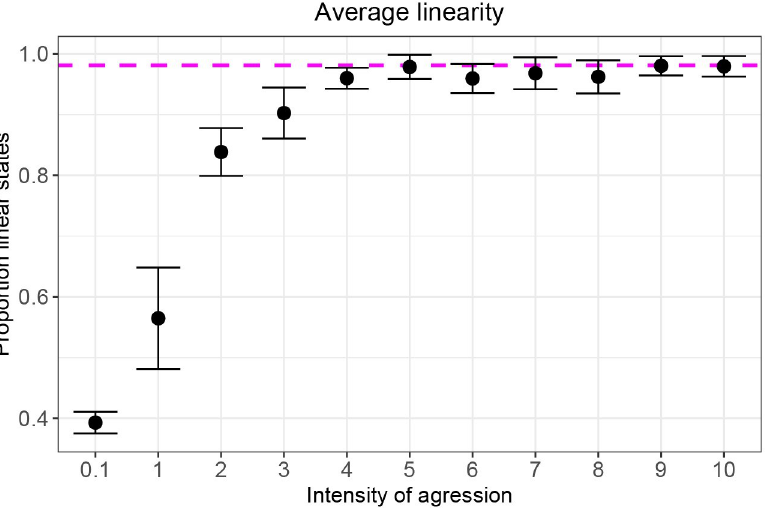
Fig 3. Average (and SE) of the hierarchical linearity measured as the proportion of transitive states for different levels of intensity of aggression. The dashed line indicates the proportion of transitive states estimated for the groups of hens in Lindquist and Chase